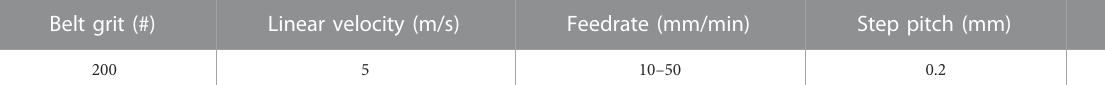
TABLE 4 Blade test grinding parameters.